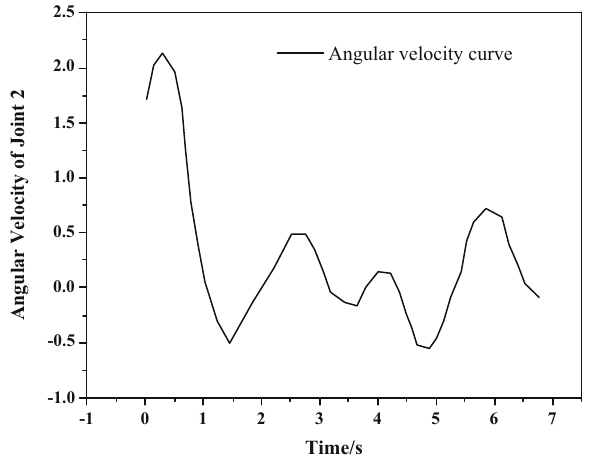
Figure 3: Angular velocity curve of optimized cubic B - spline pro - gramming joint 2.